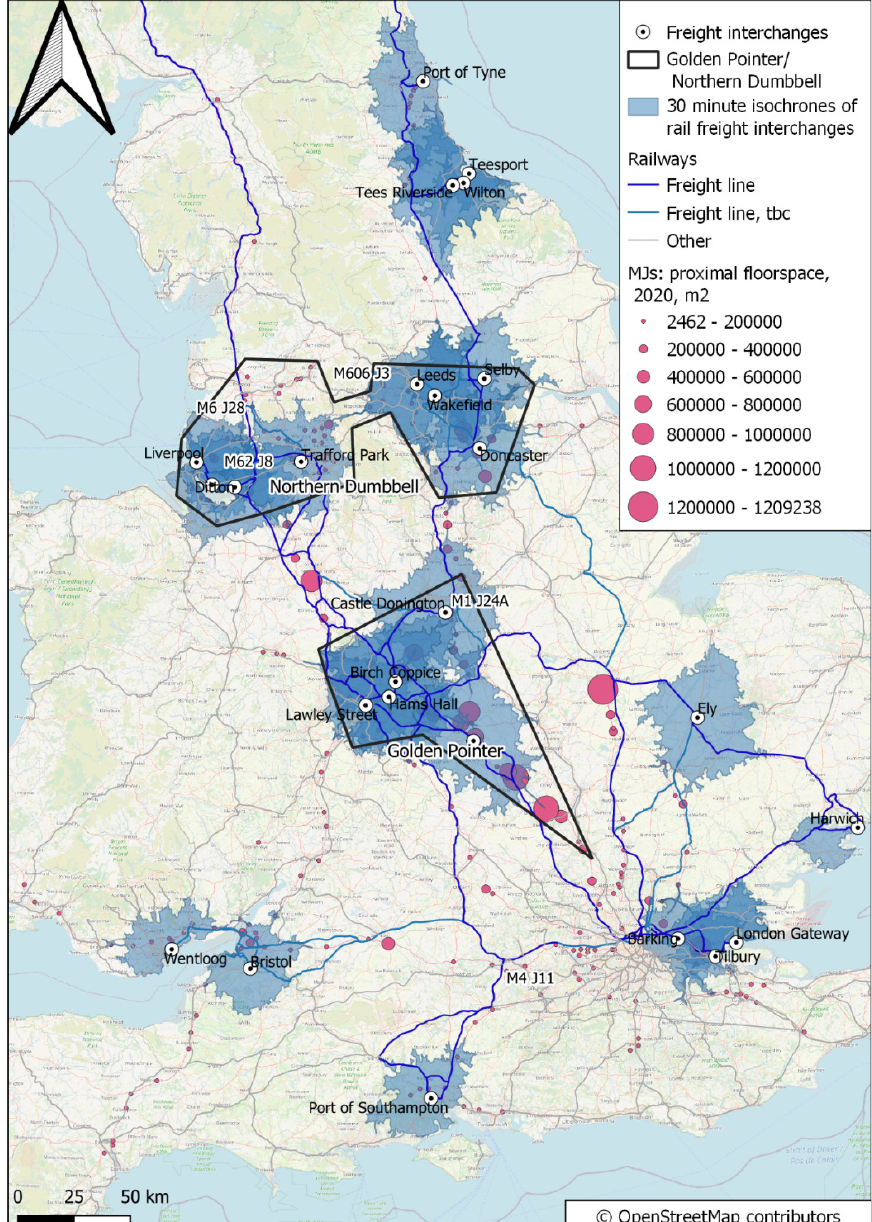
Figure 6. 2020 LDWs with 30‐minute isochrones of rail freight